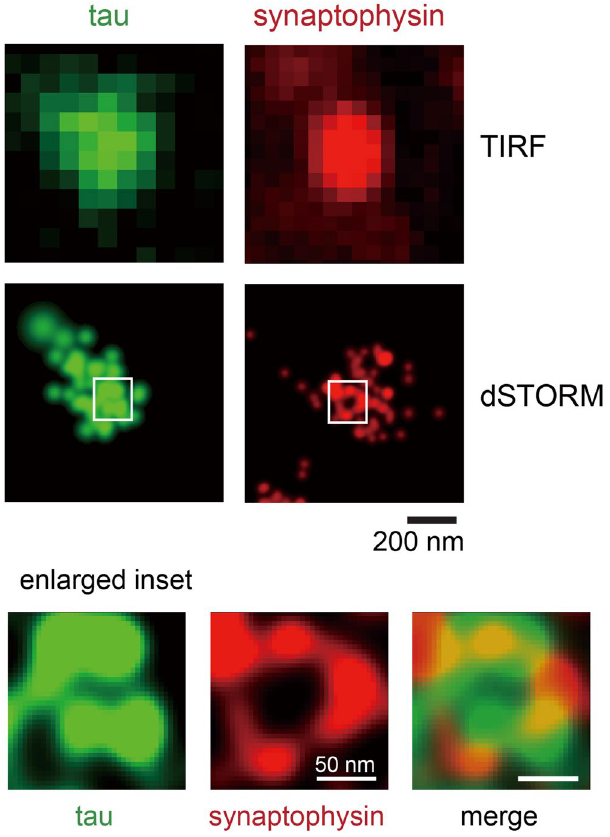
Figure 4. TIRF images of a presynaptic terminal containing tau protein, and the corresponding dSTORM image. Notice the overlap of tau with synaptic vesicles (marked by synaptophysin) in the enlarged